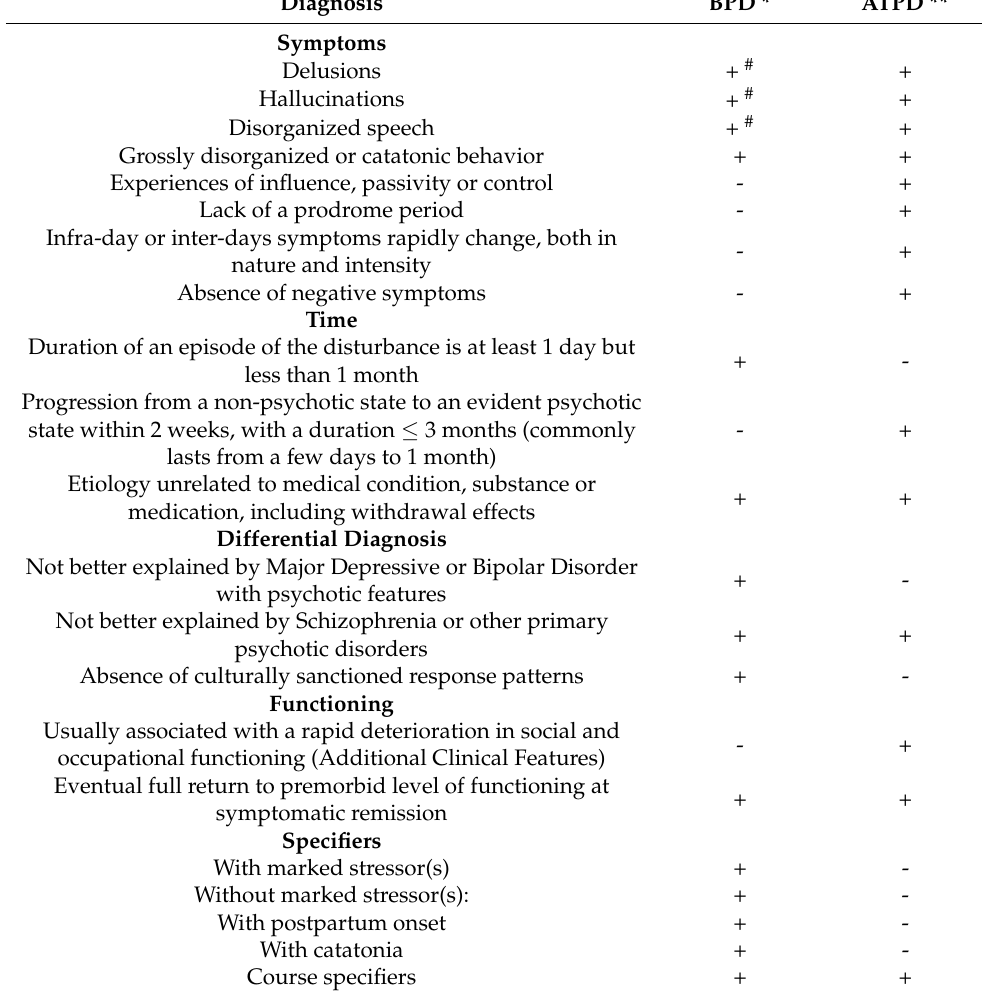
Table 1. Brief acute psychotic disorders diagnostic configuration as BPD and